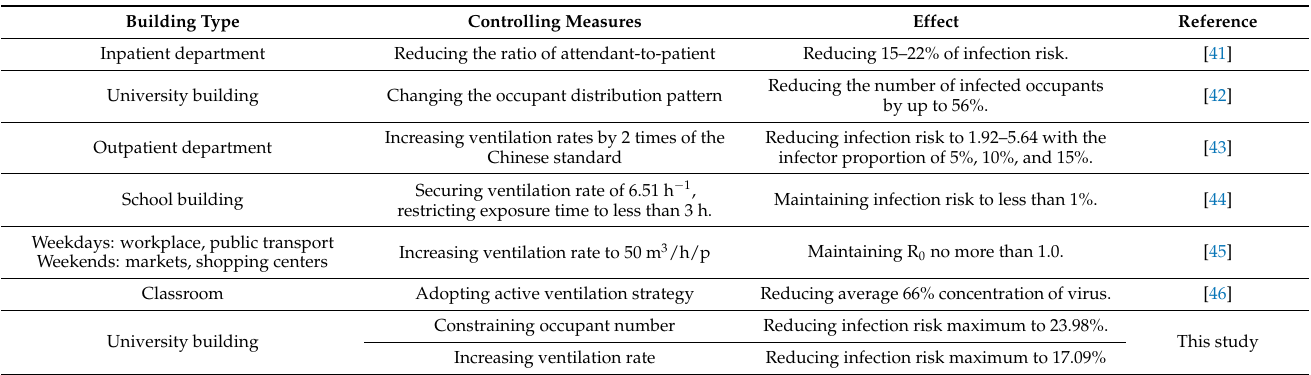
Table 6. The review and comparison of the effect of ventilation and occupant constraint on the reduction of infection